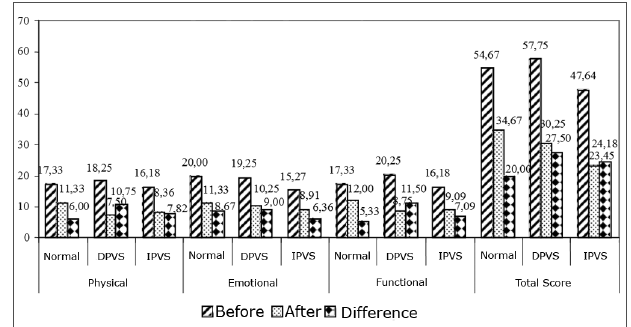
Graphic 4. Comparing the conclusions found at vector-electronystag- mography as to the differences in the Brazilian DHI.